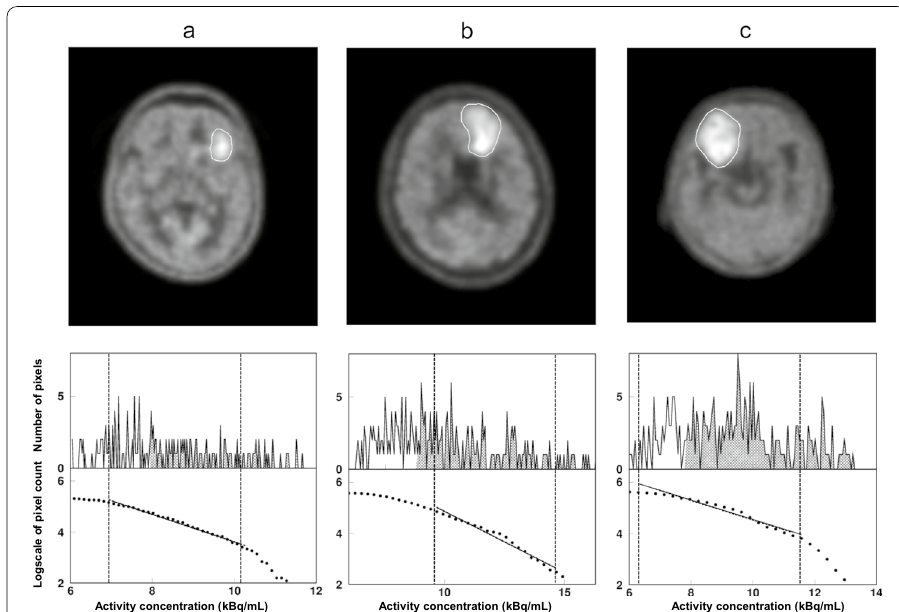
Fig. 1 PET images (upper panel) for lower grade glioma (IDH1-mutant diffuse astrocytoma) (patient no. 3 in Table 2) ( a ), higher grade glioma (IDH1-wildtype anaplastic astrocytoma) (patient no. 8 in Table 2) ( b ), and glioblastoma (patient no. 21 in Table 2) ( c ) and corresponding histograms for pixel count and logscale pixel number above the threshold as a function of pixel value (kBq/mL) in the tumor area (lower panel). The shaded area represents the numbers of pixels above thresholds, and the obtained number are plotted as the pixel number. The dashed line shows upper and lower limits for fractal analysis. The slope of the line on the points plotted indicates the fractal